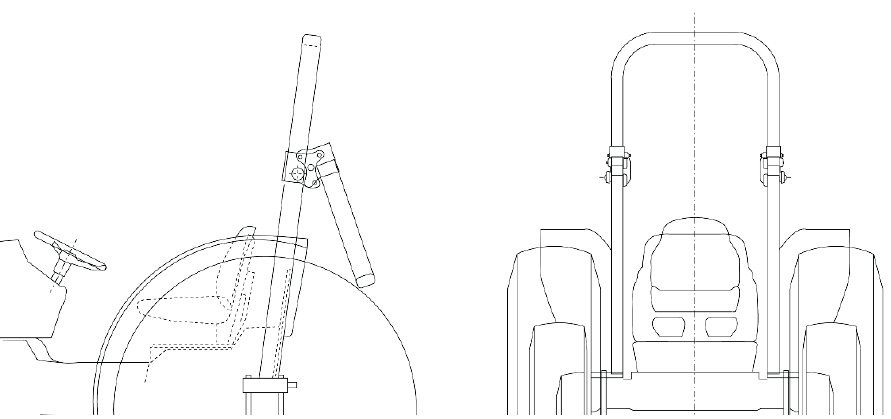
Figure 1. Side (with upper folding component in upright and folded position) and front views of a rear-FROPS.